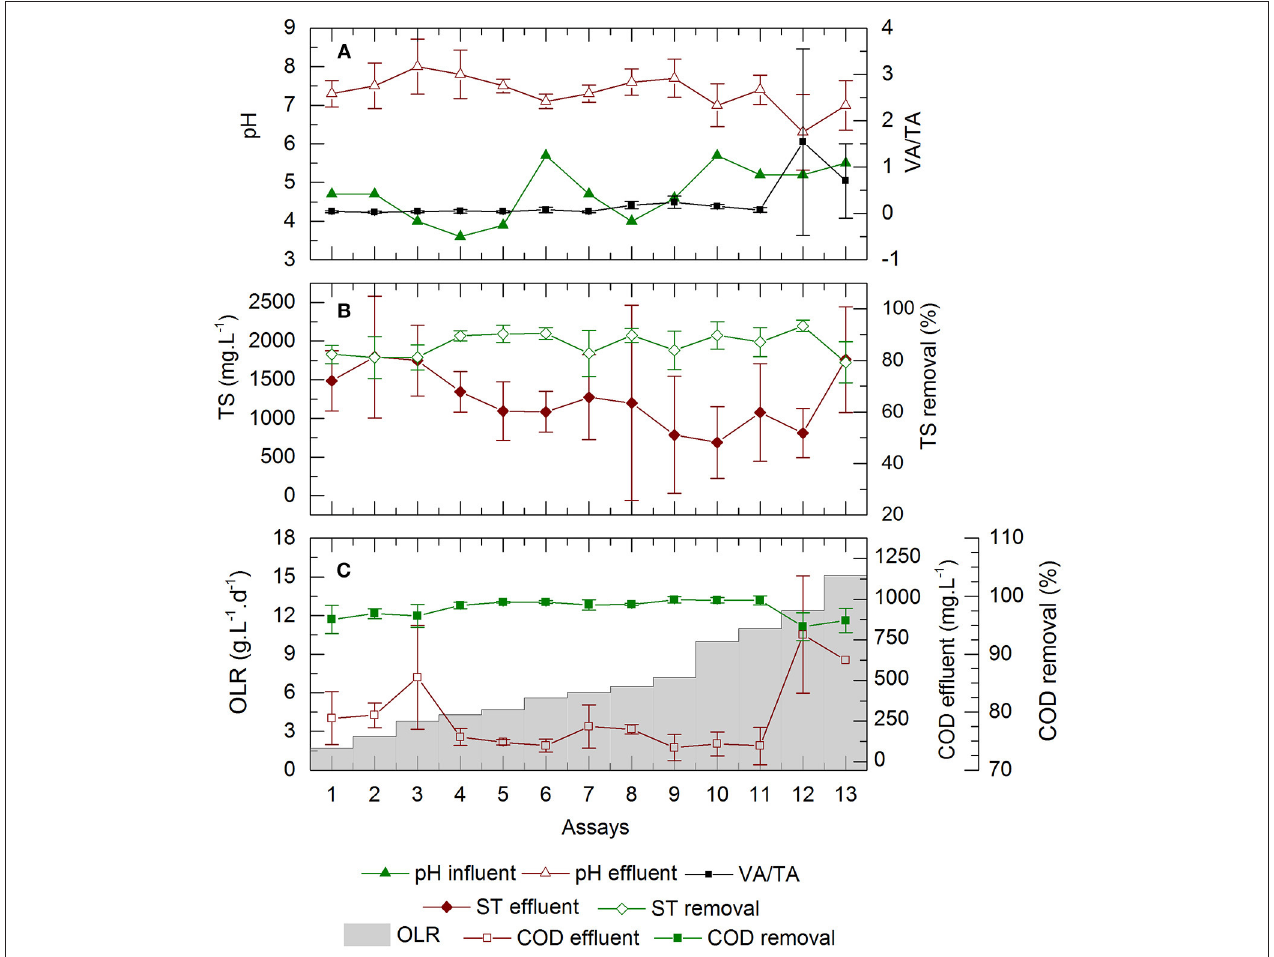
FIGURE 1 | R1 performance: (A) pH in the effluent and VA/TA ratio; (B) total solids in the effluent and total solids removal efficiency; (C) COD in effluent and COD removal